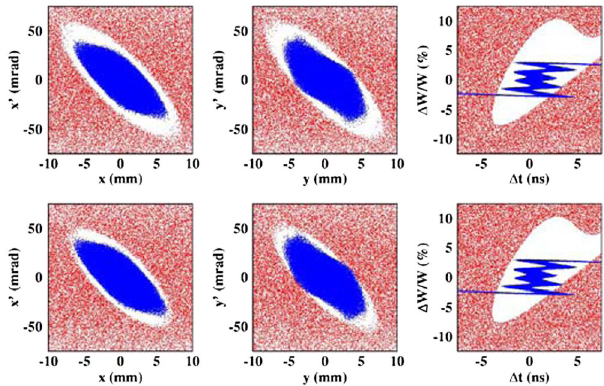
FIG. 10. Comparison of the RFQ acceptance between the original sinusoidal design (top) and the final trapezoidal vane modulation design (bottom). Realistic apertures with actual vane modulations were